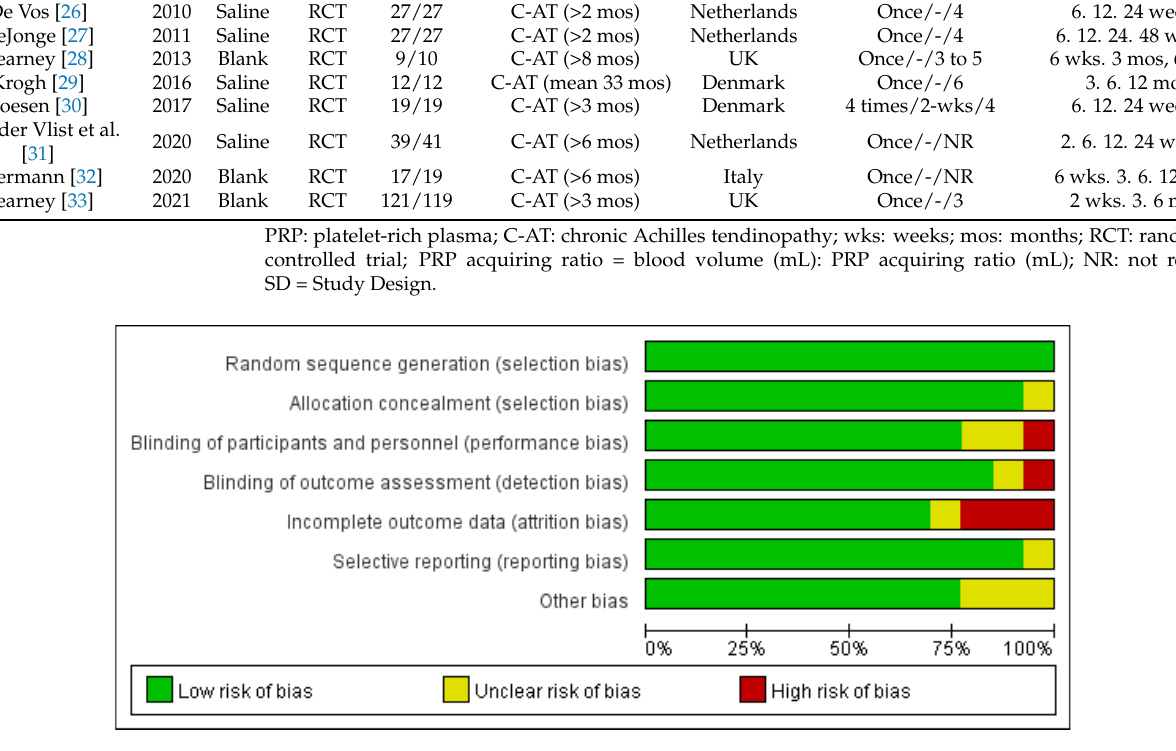
. Figure 3. Risk of bias summary diagram: assessment of specific items of bias arising from all in- cluded studies.